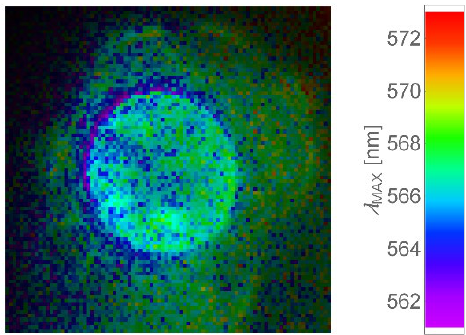
Figure 4. Detailed image of the nucleus filled with QCDs (400 µg/mL, 24 h, washed in PBS) shown in blue color and nucleus membrane represented by a violet ring. NIH/3T3 cells; field of view of 55 µm.